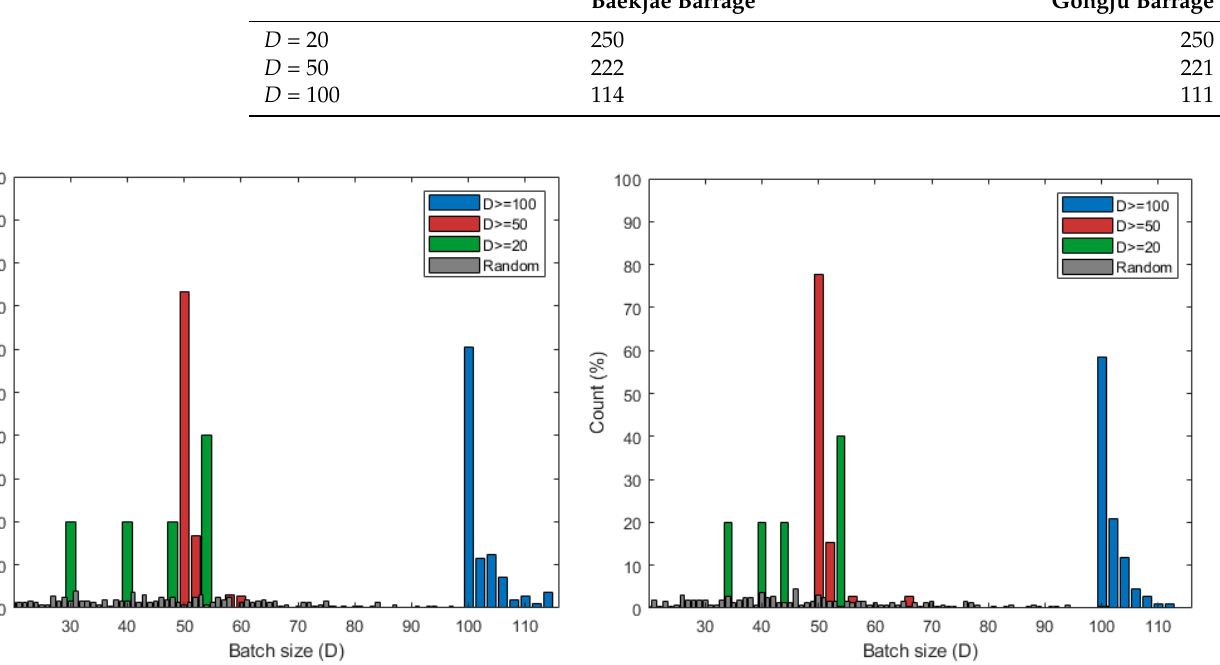
Figure 8. Data distribution of edges over D in Keum River: Baekjae barrage ( left ) and Gongju barrage ( right ). The value of Count (%) means the ratio of the number of edges according to the x -axis value compared to the cumulative total of edges that satisfy the value D during 50 iterations.